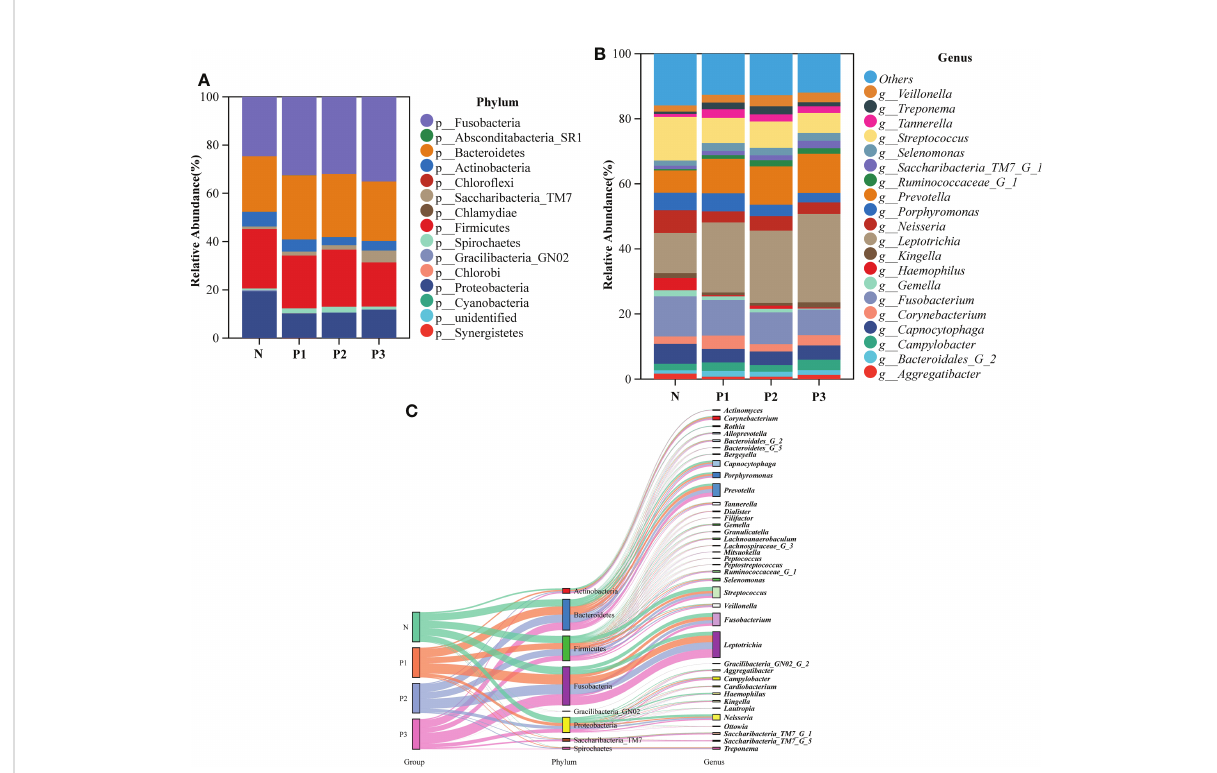
FIGURE 2 (A) The bacterial structure comparison in N, P1, P2, and P3 at the phylum level. (B) The bacterial structure comparison in the four groups at the genus level. (C) Sankey analysis of the bacterial structure comparison in the four groups at phylum and genus